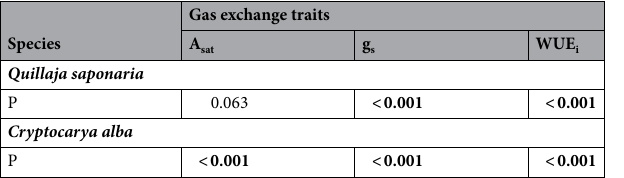
Table 3. Analysis of variance for gas exchange traits of Q . saponaria and C . alba seedlings 1 year after outplanting. P provenance, A